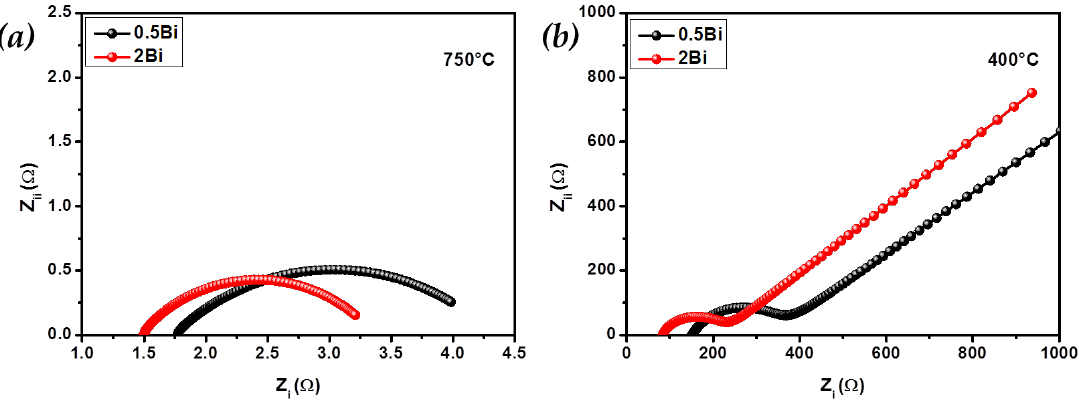
Figure 5. Nyquist plots of the sintered samples ( a ) 750 °C; ( b ) 400 °C. The different shape of the spectra requires two different fitting circuits.